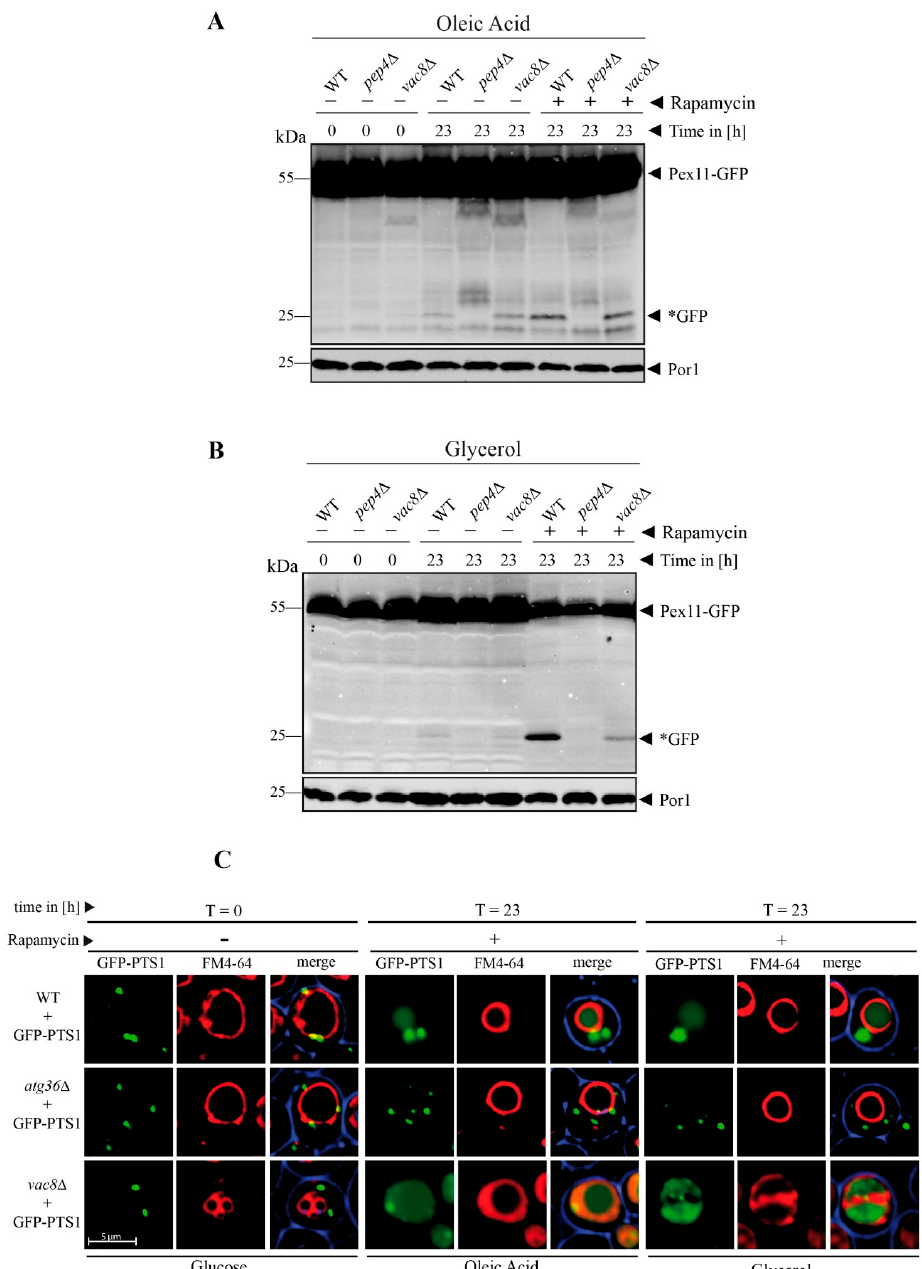
Figure 7. The peroxisome degradation-defect of vac8 Δ cells can be complemented by oleic acid and glycerol. ( A ) The degradation of peroxisomes is restored in vac8 Δ cells when the cells are shifted to oleic acid medium. The Pex11-part of the fusion protein is degraded in the vacuole together with the rest of the organelle, while the GFP portion is largely stable (*GFP). This process is blocked in pep4 Δ . ( B ) The degradation of peroxisomes is partially restored in vac8 Δ cells when the cells are shifted to glycerol medium. The Pex11 portion is degraded in the vacuole along with the rest of the organelle, while the GFP part is largely stable (*GFP). This process is inhibited in pep4 Δ . ( C ) Visualization of cellular components under the microscope during the peroxisome degradation assay. Peroxisomes were labeled with GFP-PTS1 and vacuoles were stained with FM4-64. The glucose-grown cells display the fragmented vacuolar phenotype. After the shift to glycerol or oleate, the fusion defect is nearly completely recovered and a large central vacuole can be seen. These vacuoles are able to function in peroxisomal degradation as indicated by the di ff use green staining within the